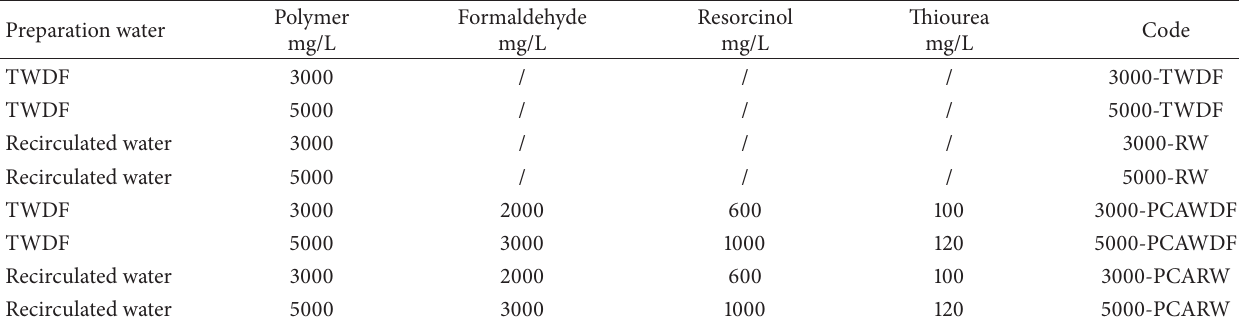
Table 1: The reagent dosage of polymer solutions and profile control agents.